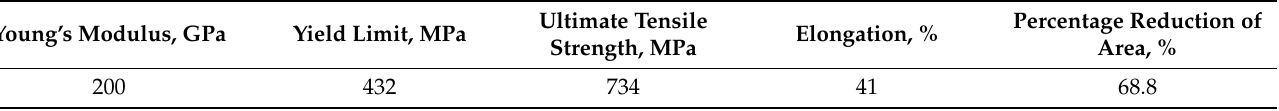
Table 2. Main mechanical properties at room temperature of the studied AISI 304 steel (as-received).